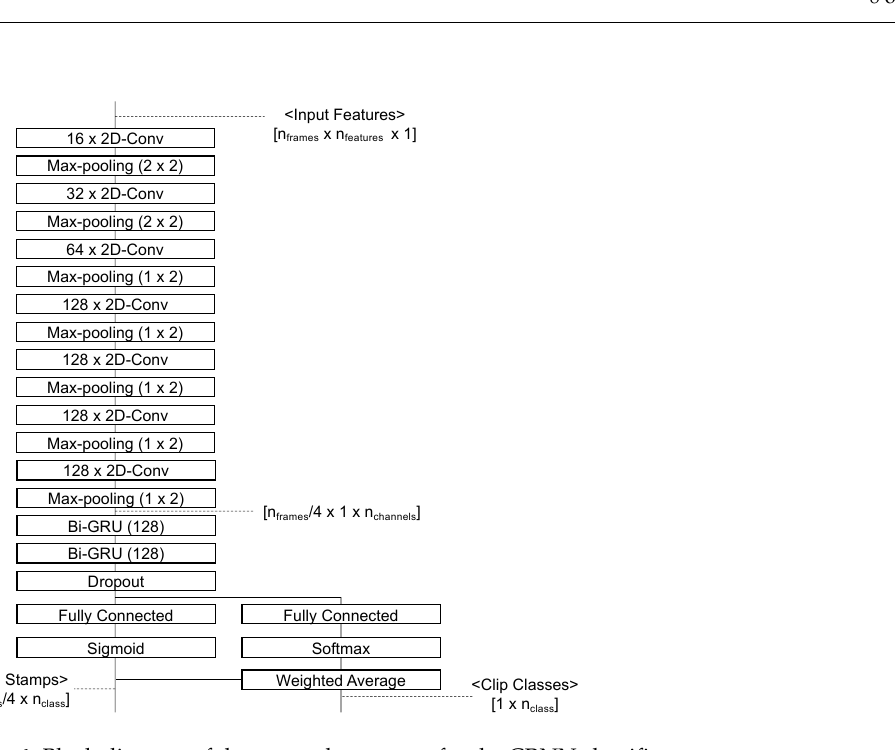
Figure 4. Block diagram of the network structure for the CRNN classifier.